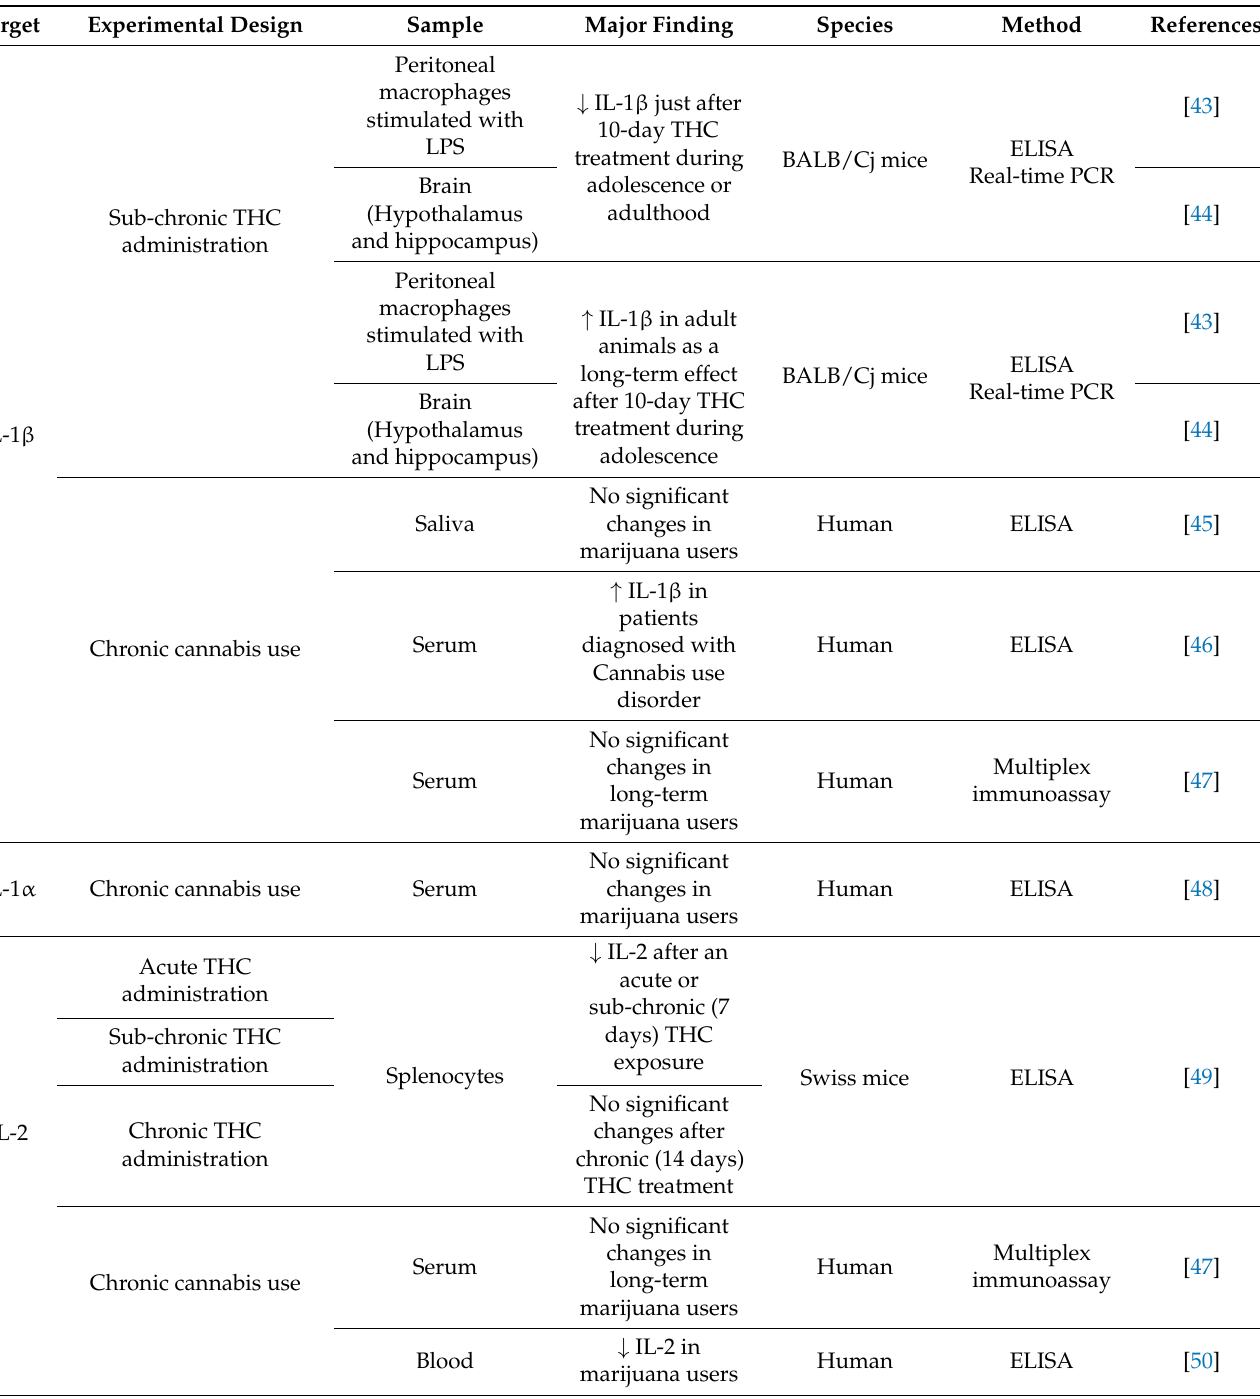
Table 1. Main findings from animal and clinical studies evaluating changes of inflammatory biomarkers after exposure to